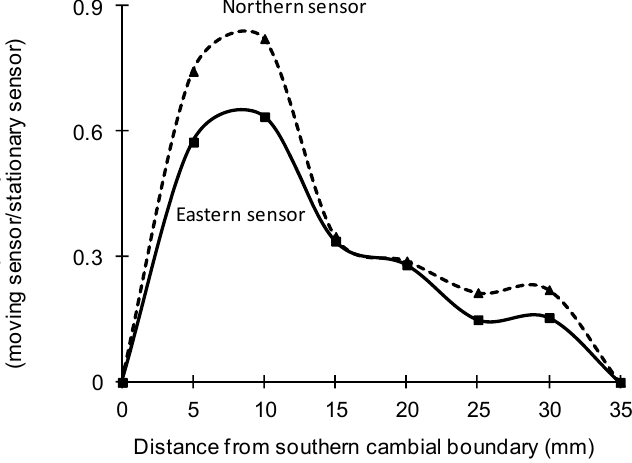
Figure 1. Typical sap velocity ratio profile for a pruned E. pilularis tree. Dashed line represents the radial profile for the northern stationary sensor and the solid line represents the radial profile for the eastern stationary sensor. The moving sensor was located on the southern aspect.